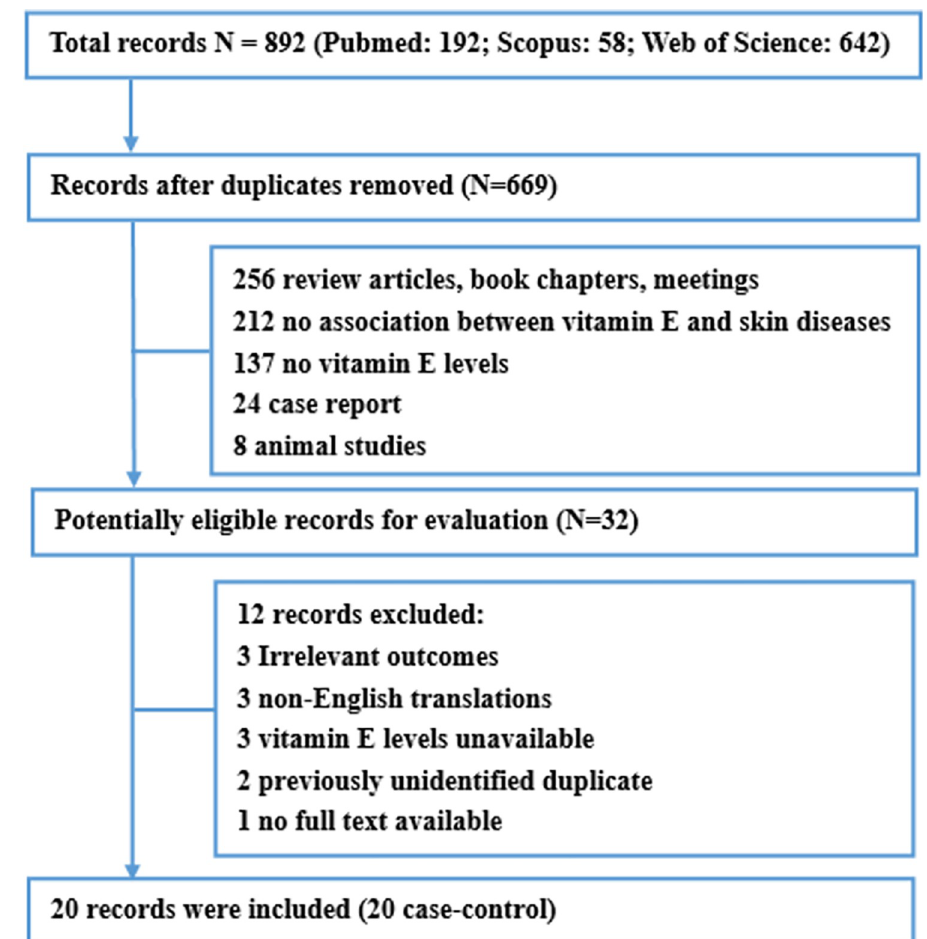
Fig 1. Flow diagram of systematic literature